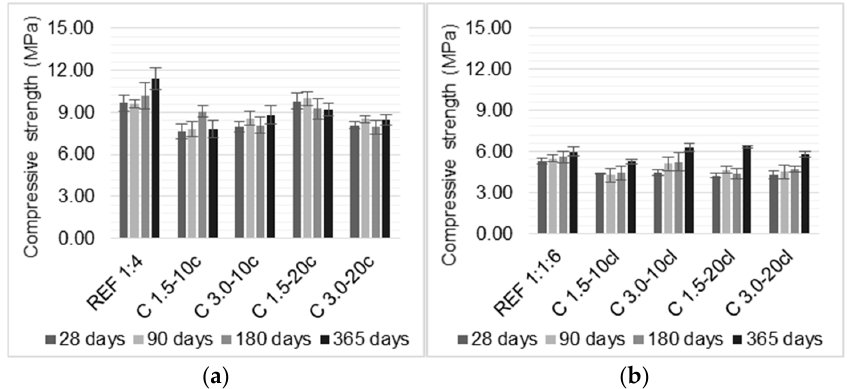
Figure 8. Compressive strength of the mortars: ( a ) cement mortars and ( b ) cement-lime mortars.